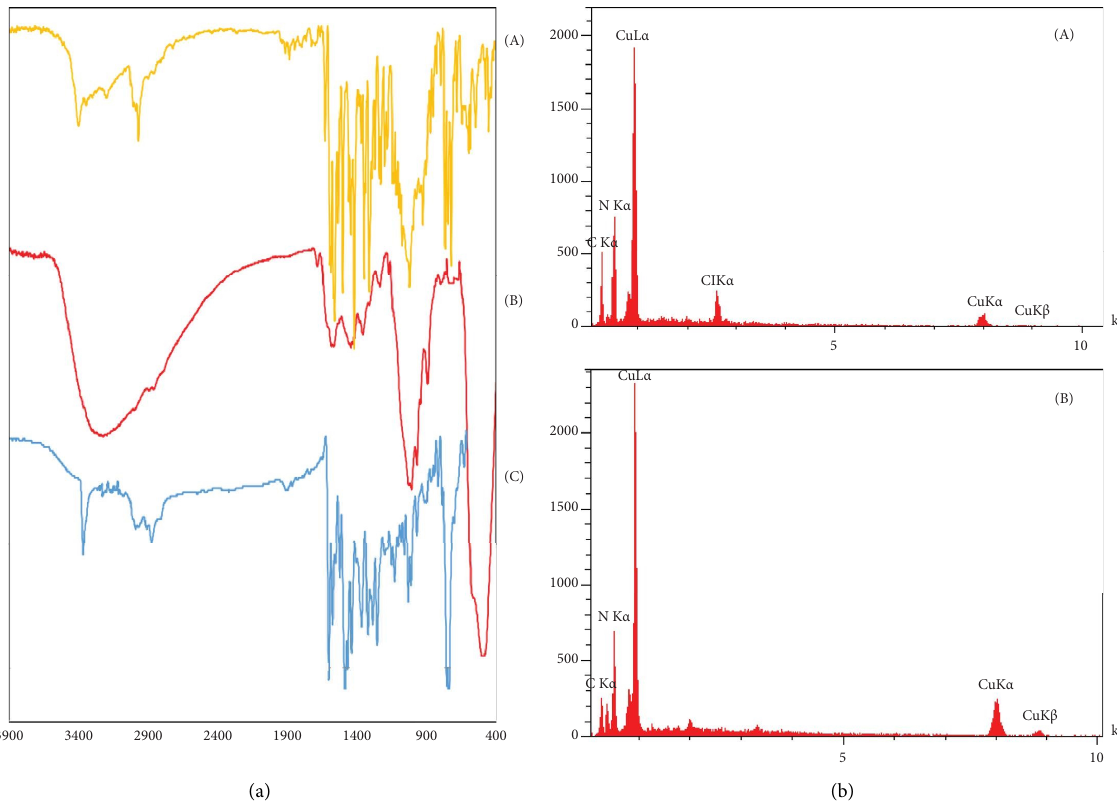
Figure 2: FT-IR spectrum. (a) Images of (A) compound VIII, (B) compound IX, and (C) compound VII. EDX spectra (b) images of (A) compound VIII and (B) compound IX.